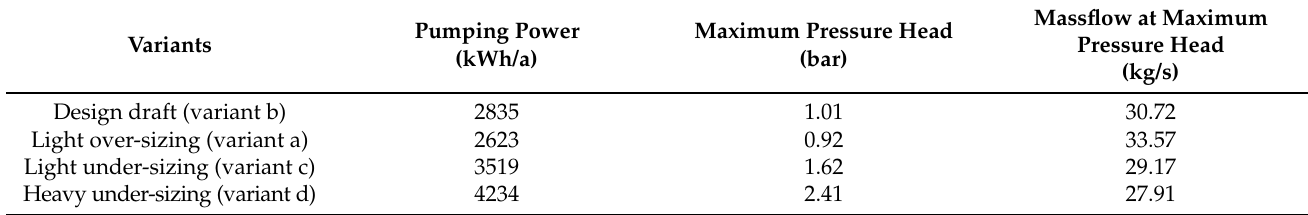
Table 1. Comparison of the different pipe sizing variants for a central pump